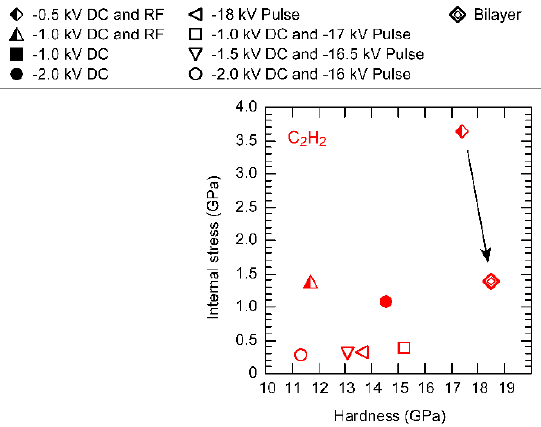
Figure 6. Hardness and internal stress of the samples prepared with C 2 H 2 as precursor gas. The preparation conditions are indicated by different symbols, as listed in the label on top. The arrow indicates the change from a single DLC layer to the bilayer.